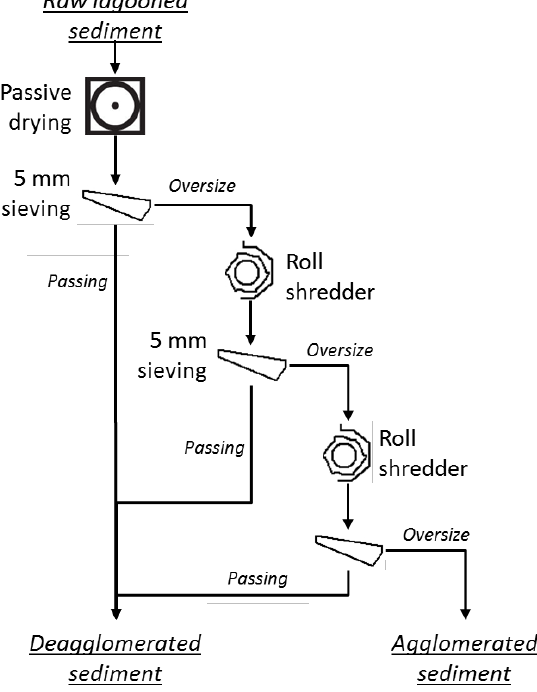
Figure 10. Deagglomeration process for the ALS sediment.